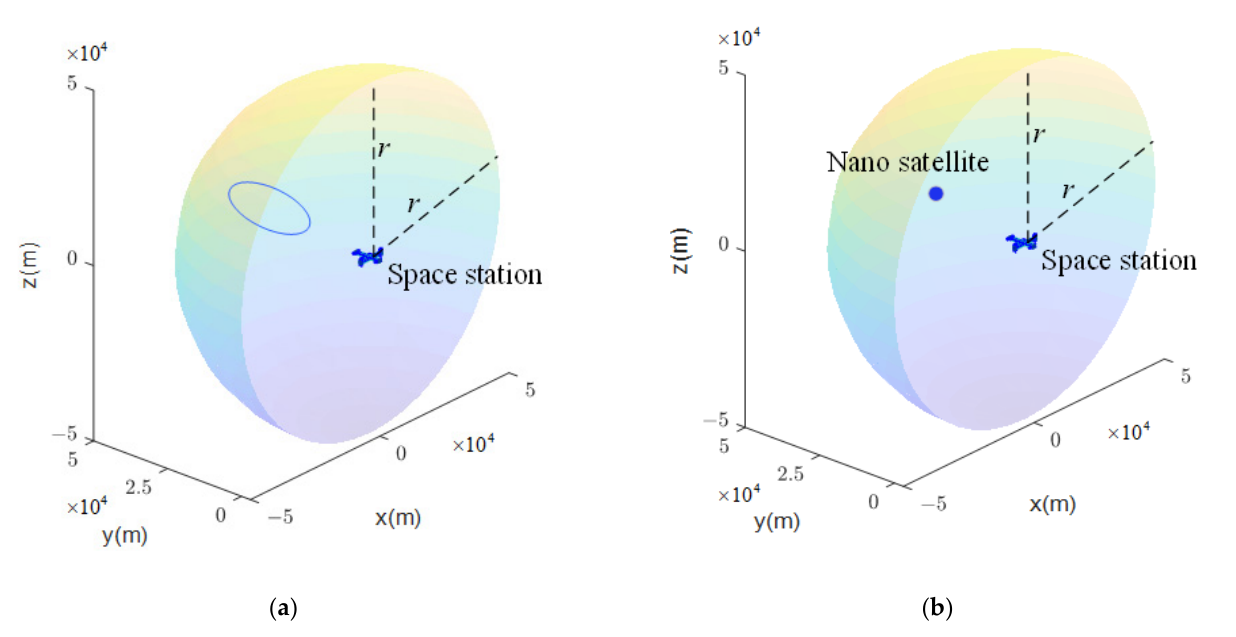
Figure 8. Collaborative detection formation scheme: ( a ) The nano-satellite conducts natural flight relative to the space station; ( b ) the nano-satellite and the space station remain in the following flight state.